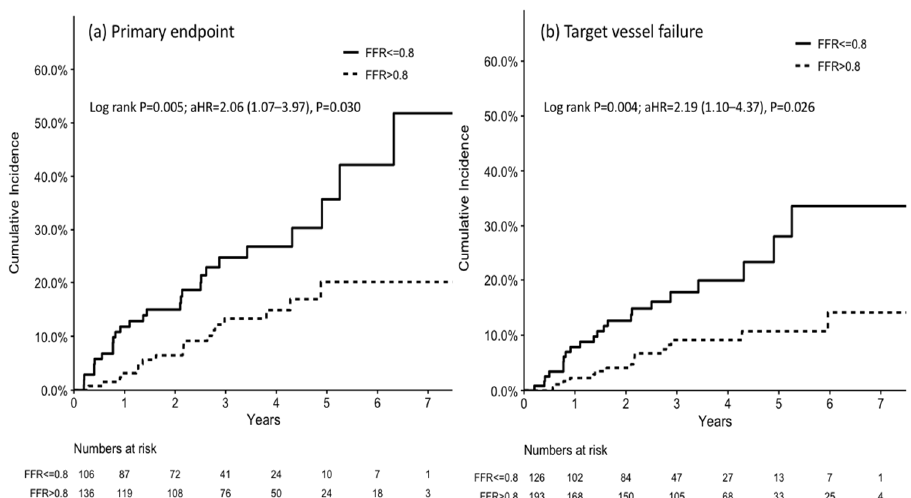
Figure 2. Kaplan–Meier curves for ( a ) the primary endpoint and ( b ) target vessel failure. The cumulative incidences of both the primary endpoint (a composite outcome of cardiac death, non-fatal myocardial infarction, and target vessel failure) and target vessel failure were higher in the revascularization (FFR ≤ 0.8) group than in the non-vascularization (FFR > 0.8) group. Abbreviations: aHR, adjusted hazard ratio; FFR, fractional flow reserve.